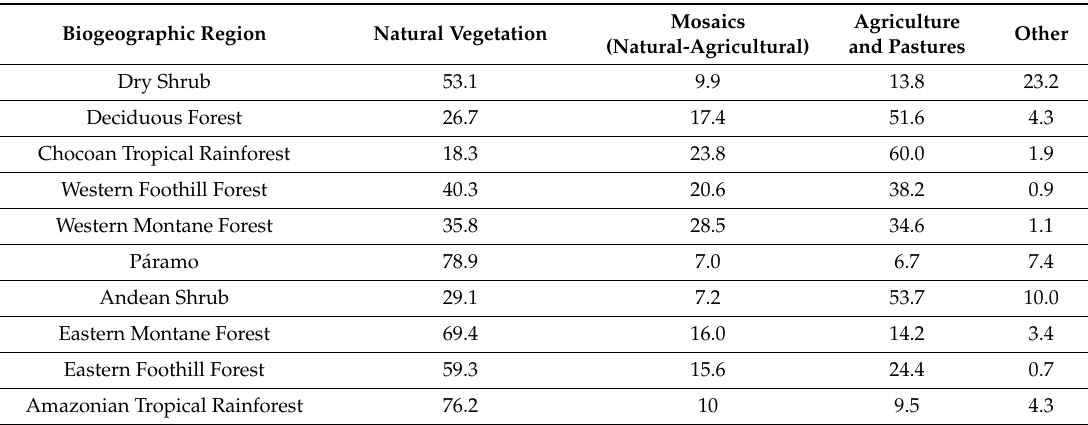
Table 3. Land cover (as percentage) in Ecuadorian biogeographic regions [66] (Figure 15). Mosaics: Mixtures of natural vegetation and either agricultural land or pastures. Other: Includes urban areas, shrimp farms, lakes, rivers, glaciers, and sand